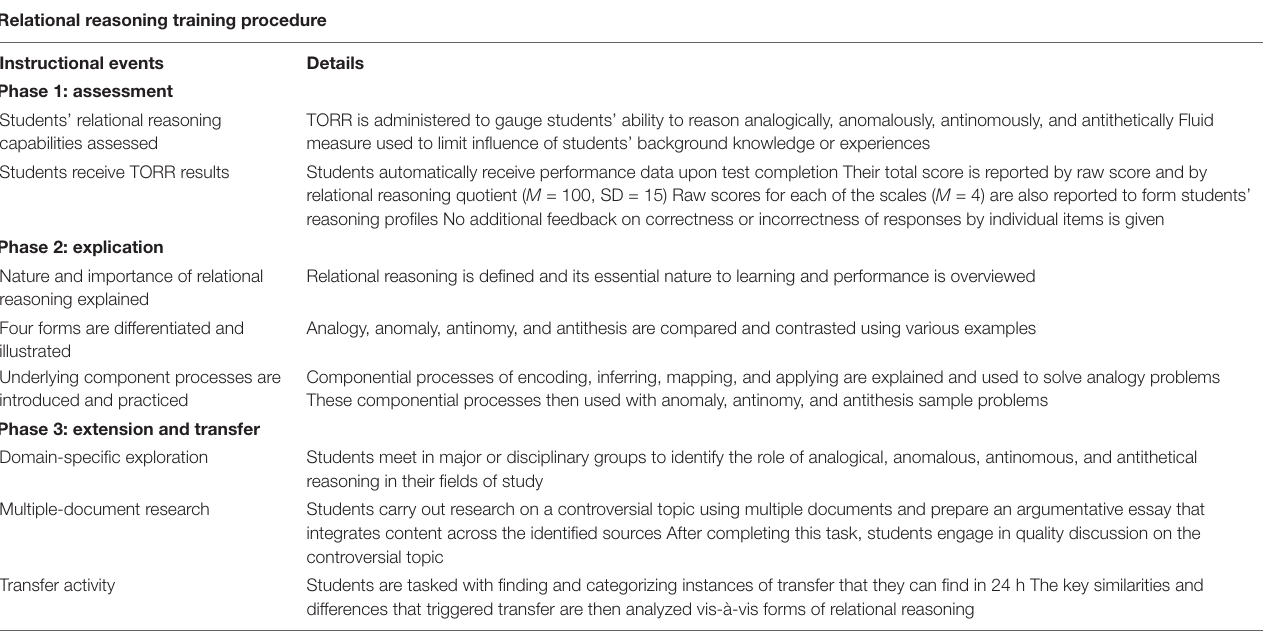
TABLE 1 | Embedding relational reasoning within a higher-education